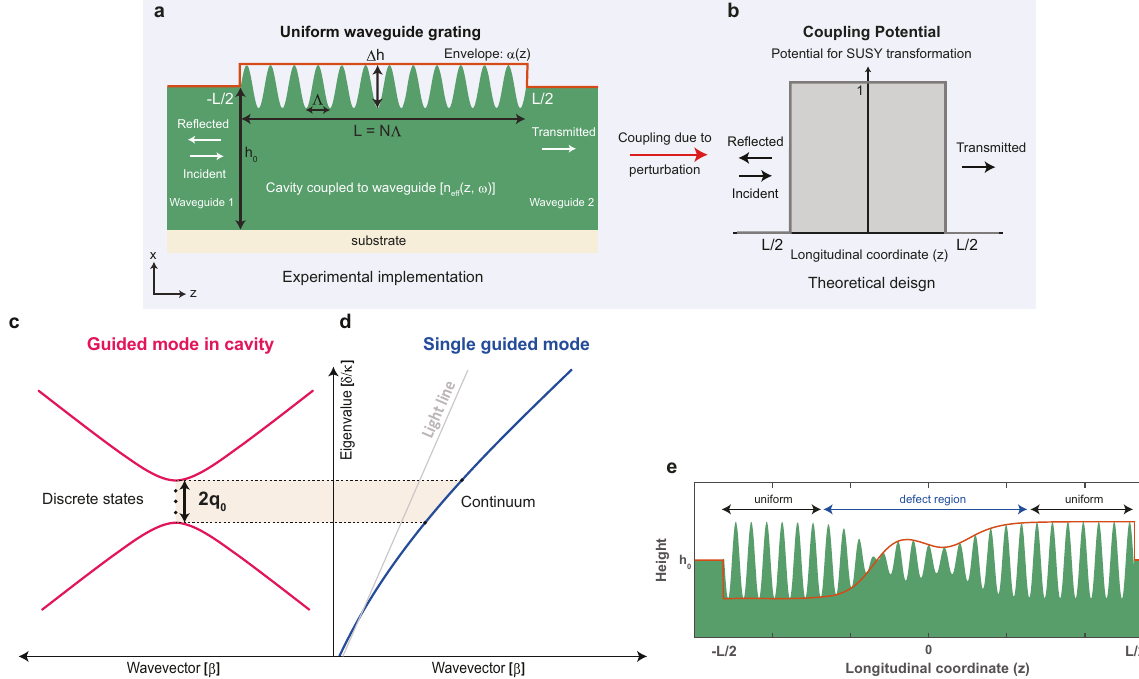
Fig. 2 One-dimensional cavity-waveguide system. a Schematic of a resonator coupled to a waveguide. Light is injected on the left at the input port and propagates in the z direction through the resonator to the output port. A uniform periodic perturbation with period Λ in the waveguide of height h 0 couples two counter-propagating modes described by the coupling parameter q 0 . b In a uniform grating, the coupling is constant along the grating region with N periods leading to the length L = N Λ , and the light gets re fl ected near the Bragg frequency. The coupling potential that depends on the effective refractive index of the waveguide n eff for a frequency ω determines the size of the bandgap in the transmission spectrum. Engineering the corrugation height Δ h with SUSY designed envelope function α ( z ) allows the cavity to support discrete modes by changing the coupling potential. c When resonators supporting discrete states in the bandgap are connected to an unperturbed waveguide ( d ) with continuous dispersion, they form a scattering channel for the decay of the con fi ned photonic states. e Surface corrugation envelope (orange) of resonators supporting three states in the bandgap obtained by 2-SUSY. The corrugation has been magni fi ed for